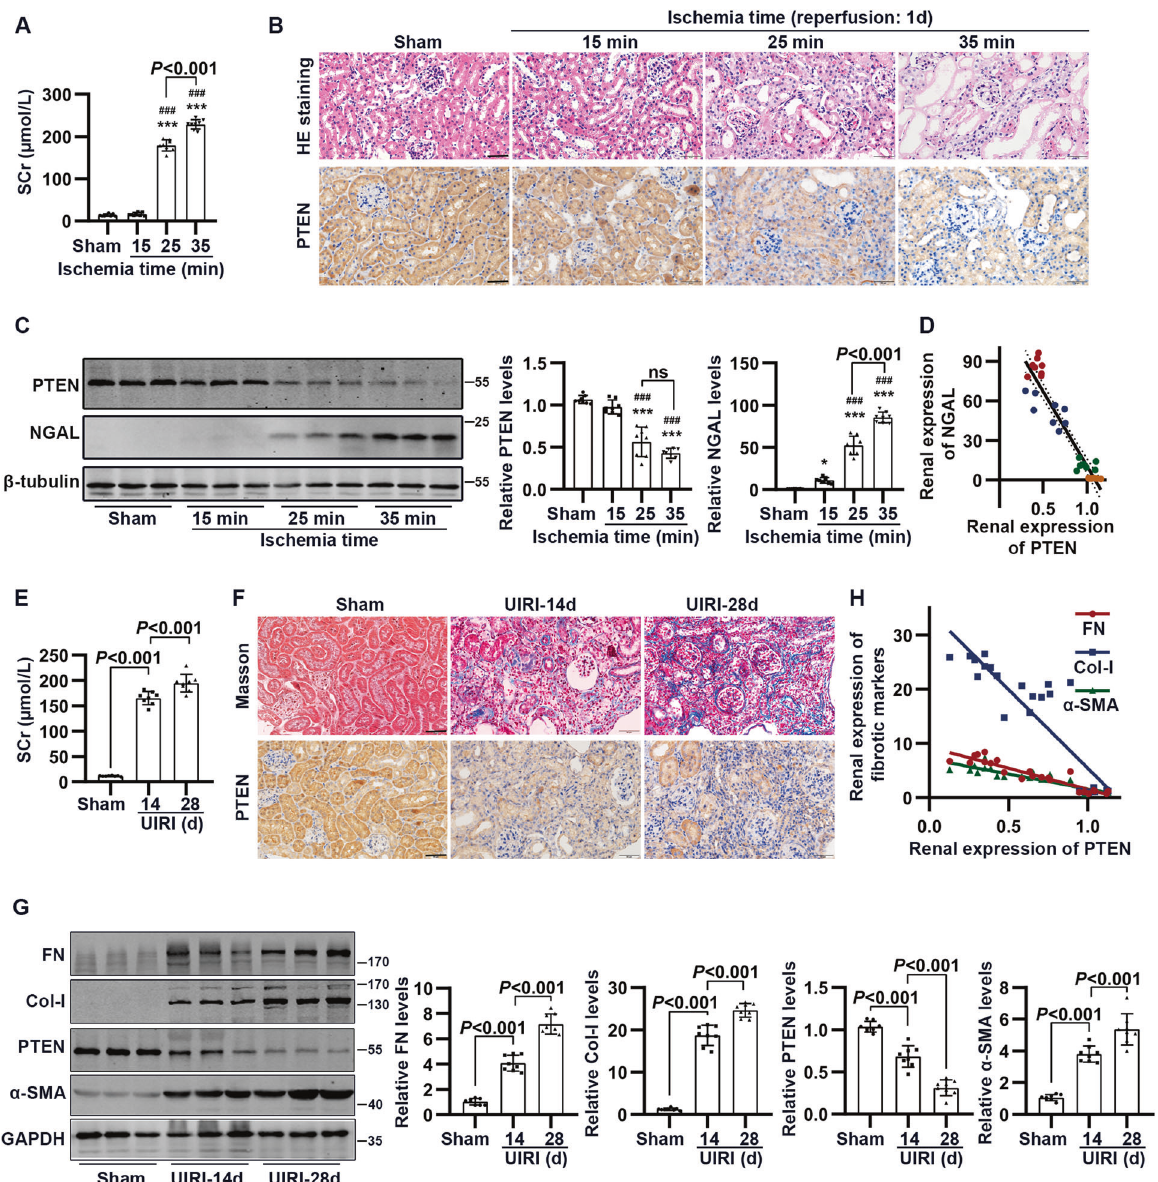
Fig. 1 PTEN expression in kidney subjected to I/R-induced renal injury and maladaptive repair. A Concentration of serum creatinine (SCr) in mice subjected to bilateral renal artery obstruction at the indicated times, followed by 24 h of reperfusion (BIRI). B Representative HE staining and immunohistochemical staining of PTEN in kidney subjected to BIRI (scale bar, 50 μ m). C Western blotting analysis showing changes in PTEN and NGAL in renal cortex subjected to BIRI (* P < 0.05; and *** P < 0.001 compared with values in the sham group; ### P < 0.001 compared with values in BIRI-15 min ischemia group; n = 8 mice in each group). D Correlation analysis between renal expression of PTEN and NGAL (sham, orange; BIRI-15 min, green; BIRI-25 min, blue; and BIRI-35 min, red dots). E Concentration of SCr in mice subjected to unilateral renal artery obstruction for 30 min, followed by 14 and 28 days of normal feeding (UIRI). F Representative Masson staining and immunohistochemical staining of PTEN in kidney subjected to UIRI (scale bar, 50 μ m). G Western blotting analysis showing changes in PTEN and fi brotic proteins in renal cortex subjected to UIRI ( n = 8 mice in each group). H Correlation analysis between renal expression of PTEN and fi brotic